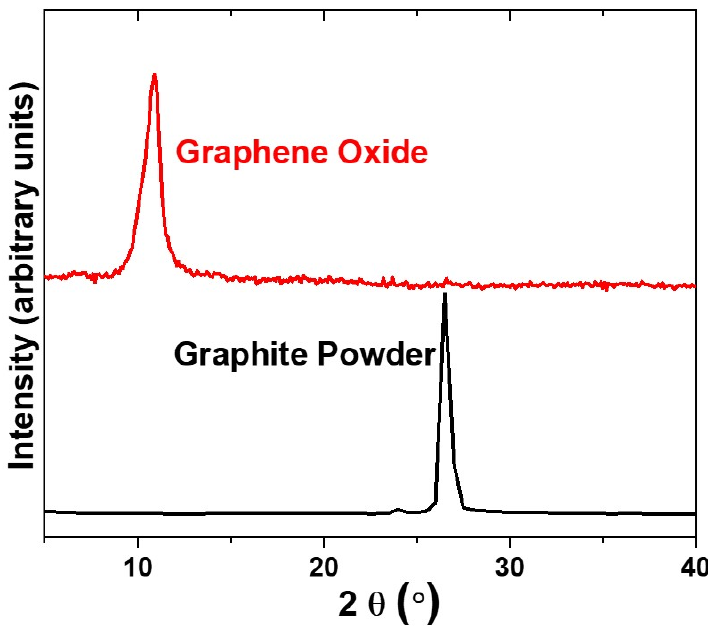
Figure 3. XRD pattern of the graphite powder starting reactant ( bottom ) and graphene oxide final product ( top ).